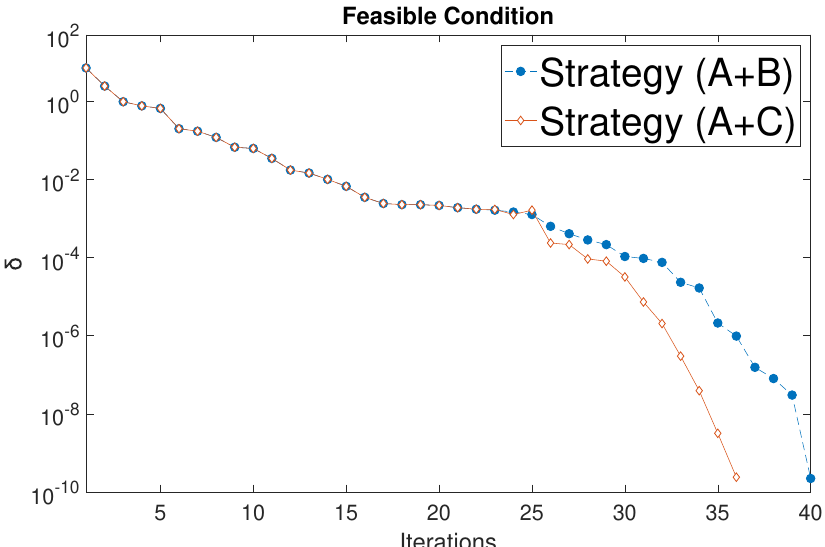
Figure 8. The 14 bus constraint violation. δ is the violations of constraints. Regionalization strategies generated by Automatic Regionalization (AR) and denote Topology Based Similarity (TBS)-AR as strategy A, Measurement-Based Similarity (MBS)-AR as B and Weighted Measurement-Based Similarity (WMBS)-AR as C. Strategy A+B (blue line) is the combination of regionalization strategies A and B, Strategy A+C (red line) is the combination of regionalization strategies A and